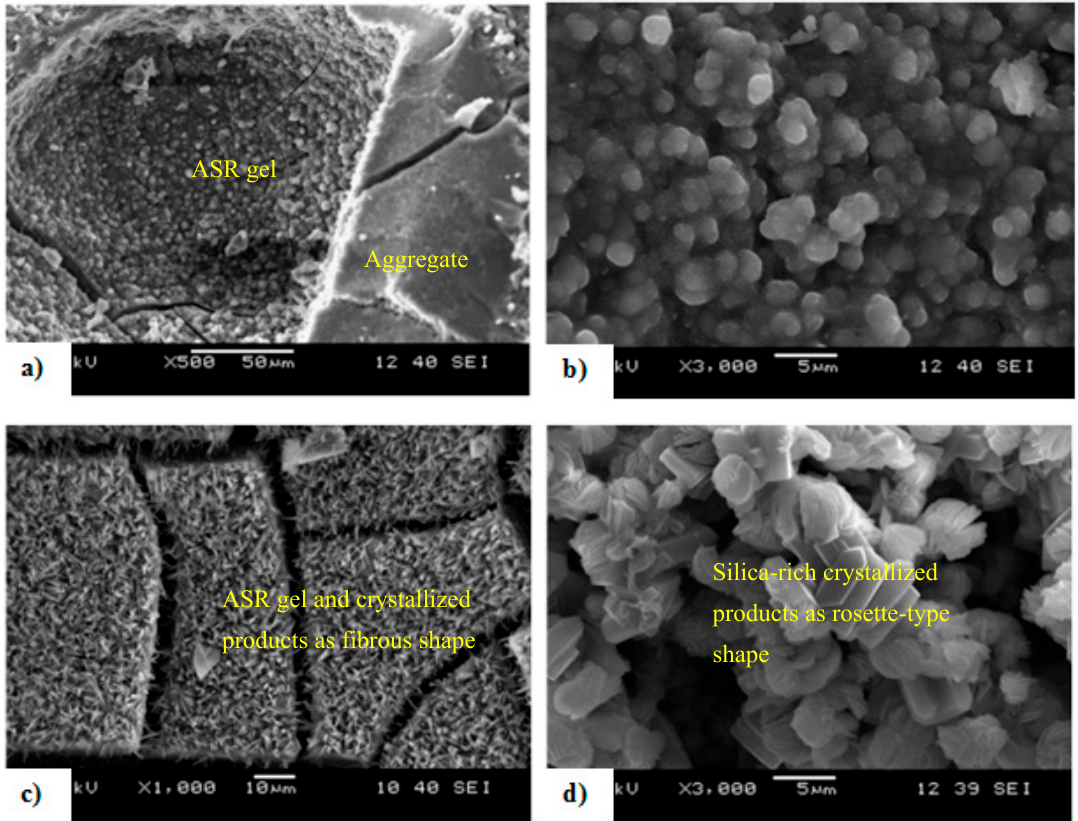
Figure 5. SEM image of ( a ) ASR product, ( b ) semi-organized products filling the pores in cement paste, ( c ) cracked products having a fibrous morphology and ( d ) a rosette-type morphology (adapted from [88] ).